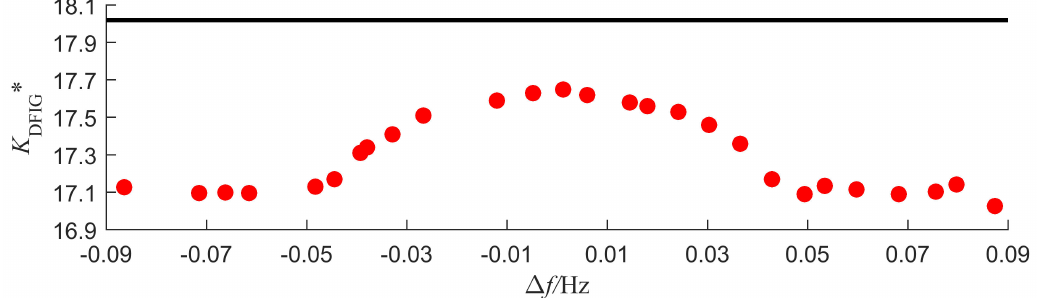
Figure 13. Theoretical and simulated K DFIG * under di ff erent events, the solid line for the K DFIG * calculated from an equation, the dots for the K DFIG * calculated from